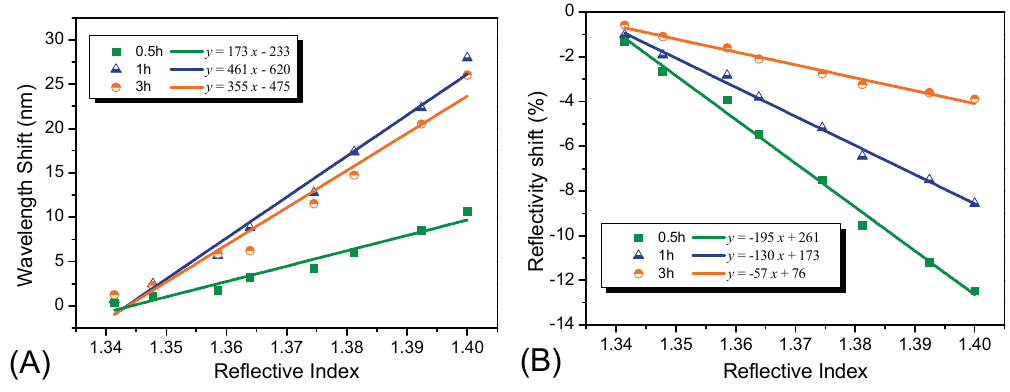
Figure 5. Refractive index sensitivities of the Ag NP-based sensors with different coating time of 0.5 h, 1 h, and 3 h. ( A ) illustrates the wavelength shifts comparison of the Ag NP-based sensors with three different coating times; ( B ) illustrates the optical intensity shifts comparison of the Ag NP-based sensors with three different coating